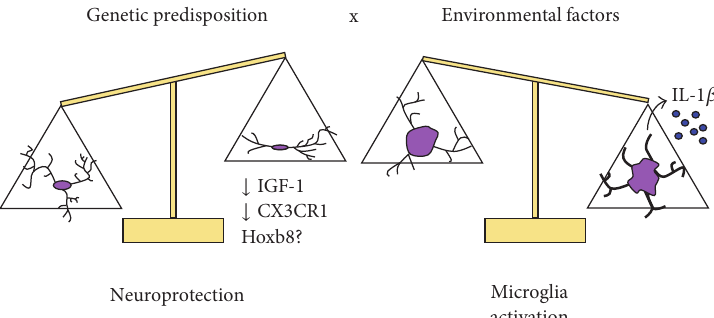
Figure 1: Gene X environment interaction in the pathophysiology of abnormal repetitive behaviors. Under normal conditions, IGF-1 expressing microglia provide neuroprotection, communicating with neurons via the CX3CL1/CX3CR1 signaling pathway. Failure of these interactions may lead to impaired neuroprotective support. In this context, in the face of an environmental stimulus, like an immunological challenge,dysregulatedinflammatorymicroglialactivationmayleadtotheinductionofinflammatorycytokinessuchasIL-1 𝛽 andtoneuronal damage.